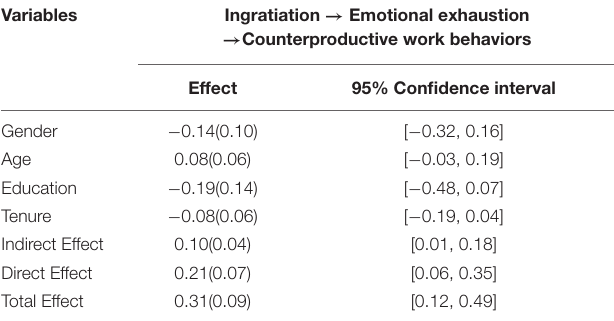
TABLE 4 | Results of mediation effect